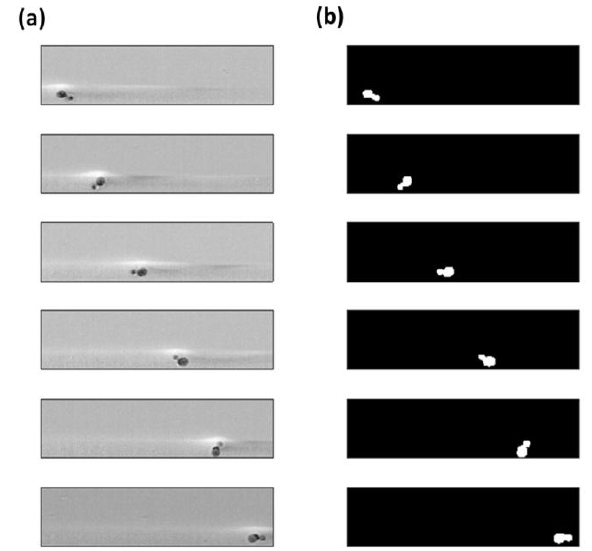
Figure 8. In-plane rotation device: ( a ) In the six consecutive frames, a cell close to the channel wall is induced in rotation; ( b ) The same frames are converted in binary images.